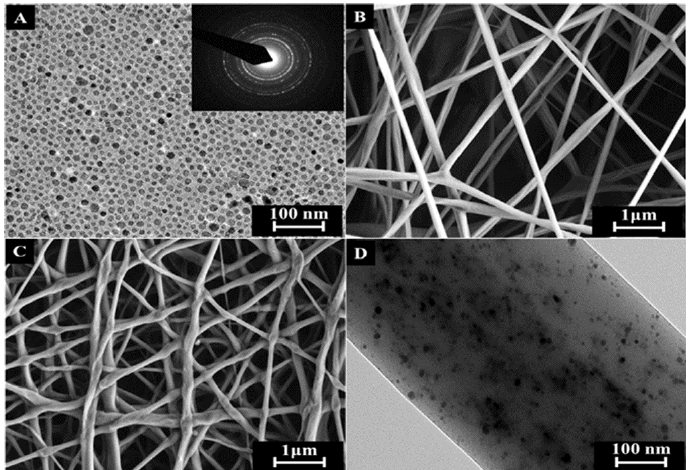
Figure 7. ( A ) TEM image of the iron oxide NPs (the inset shows the corresponding selected-area electron diffraction pattern), ( B , C ) FESEM images of electrospun PLGA (poly lactic-co-glycolic acid) NFs and magnetic NF matrix, respectively, ( D ) TEM image of MNF. Reprinted with permission from reference [94]. Copyright Elsevier, 2016.